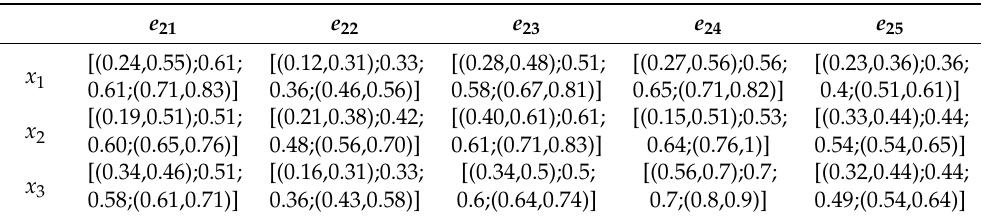
Table A15. The influencing factors of B 2 in the whole time period belong to the comprehensive evaluation value of different risks.